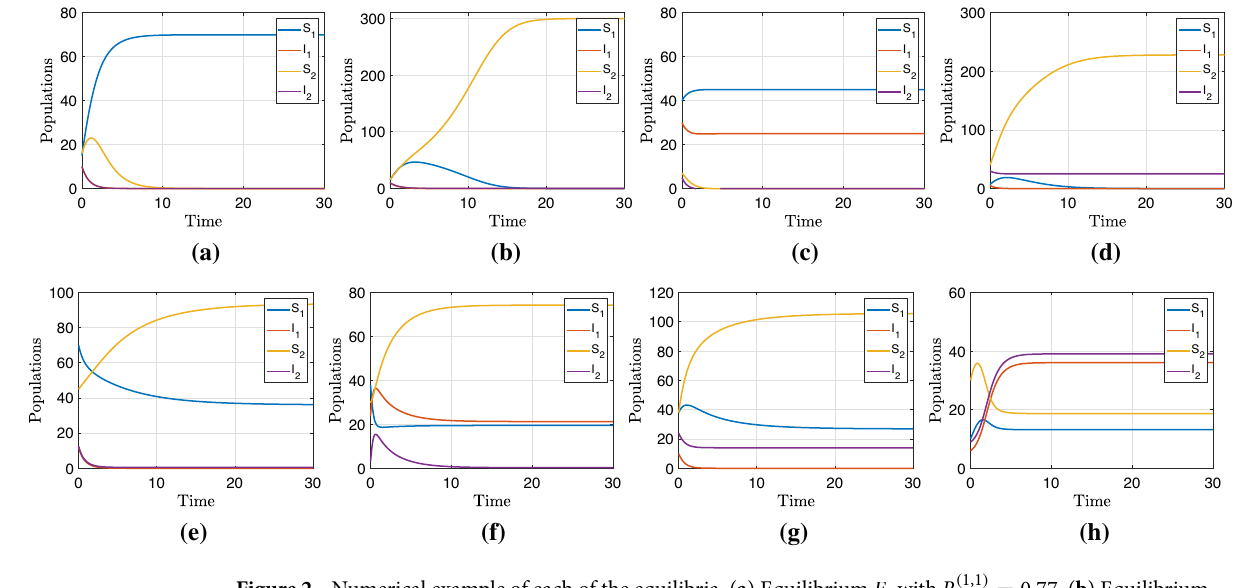
Figure 2. Numerical example of each of the equilibria. ( a ) Equilibrium E 1 with R E 2 with R ( 1,2 ) 0